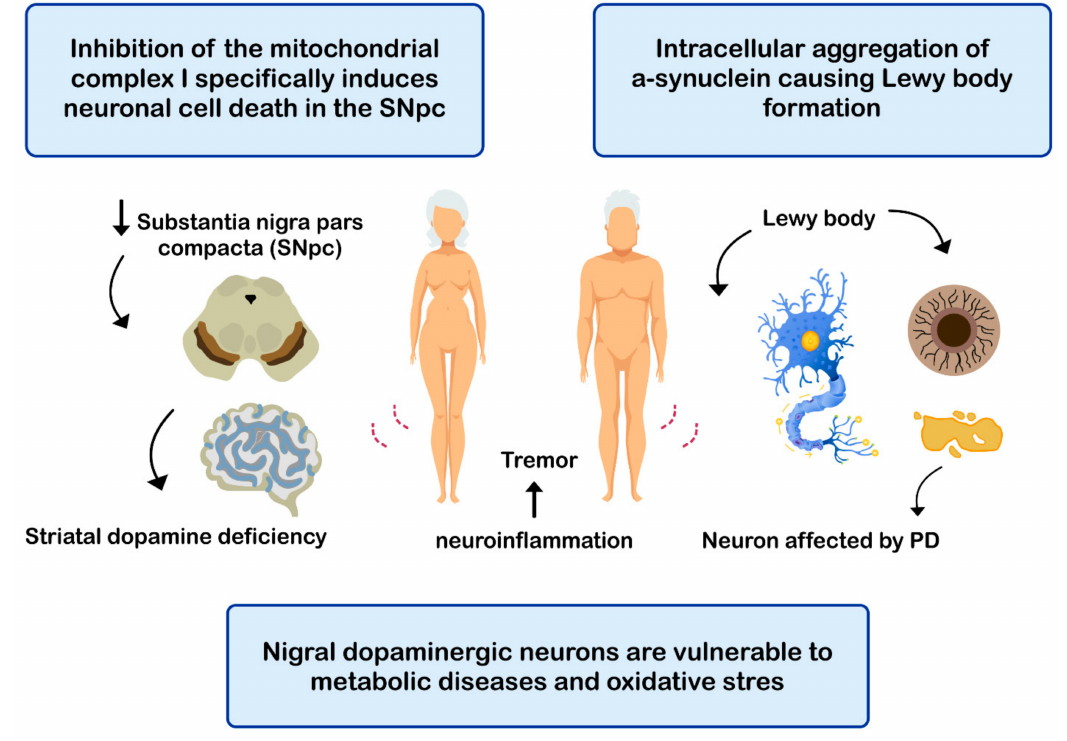
Figure 4. Mechanisms related with the pathogenesis of Parkinson’s disease